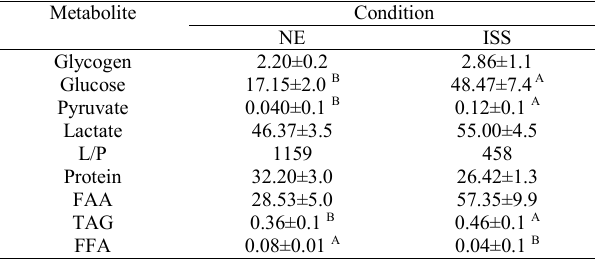
Table 3. Metabolic profile of white muscle of Brycon amazonicus submitted to ISS. Juvenile ‘matrinxã’ were submitted to intermittent sustained swimming (ISS) at 1.0 Body-Length sec -1 for 30 days. NE - non exercise; ISS - 12/ 12h (swimming/still). Glycogen (µmol of glycosyl-glucose (g protein) -1 ); glucose (nmol g -1 ); pyruvate (µmol g -1 ); lactate (µmol g -1 ); L/P - lactate/pyruvate ratio; protein (mg g -1 ); FAA - free amino acids (µmol g -1 ); TAG - triacylglycerol (mg g -1 ), FFA - free fatty acids (µmol g -1 ); TAG/FFA ratio. Superscript letters mean significant difference between conditions for the same parameter at